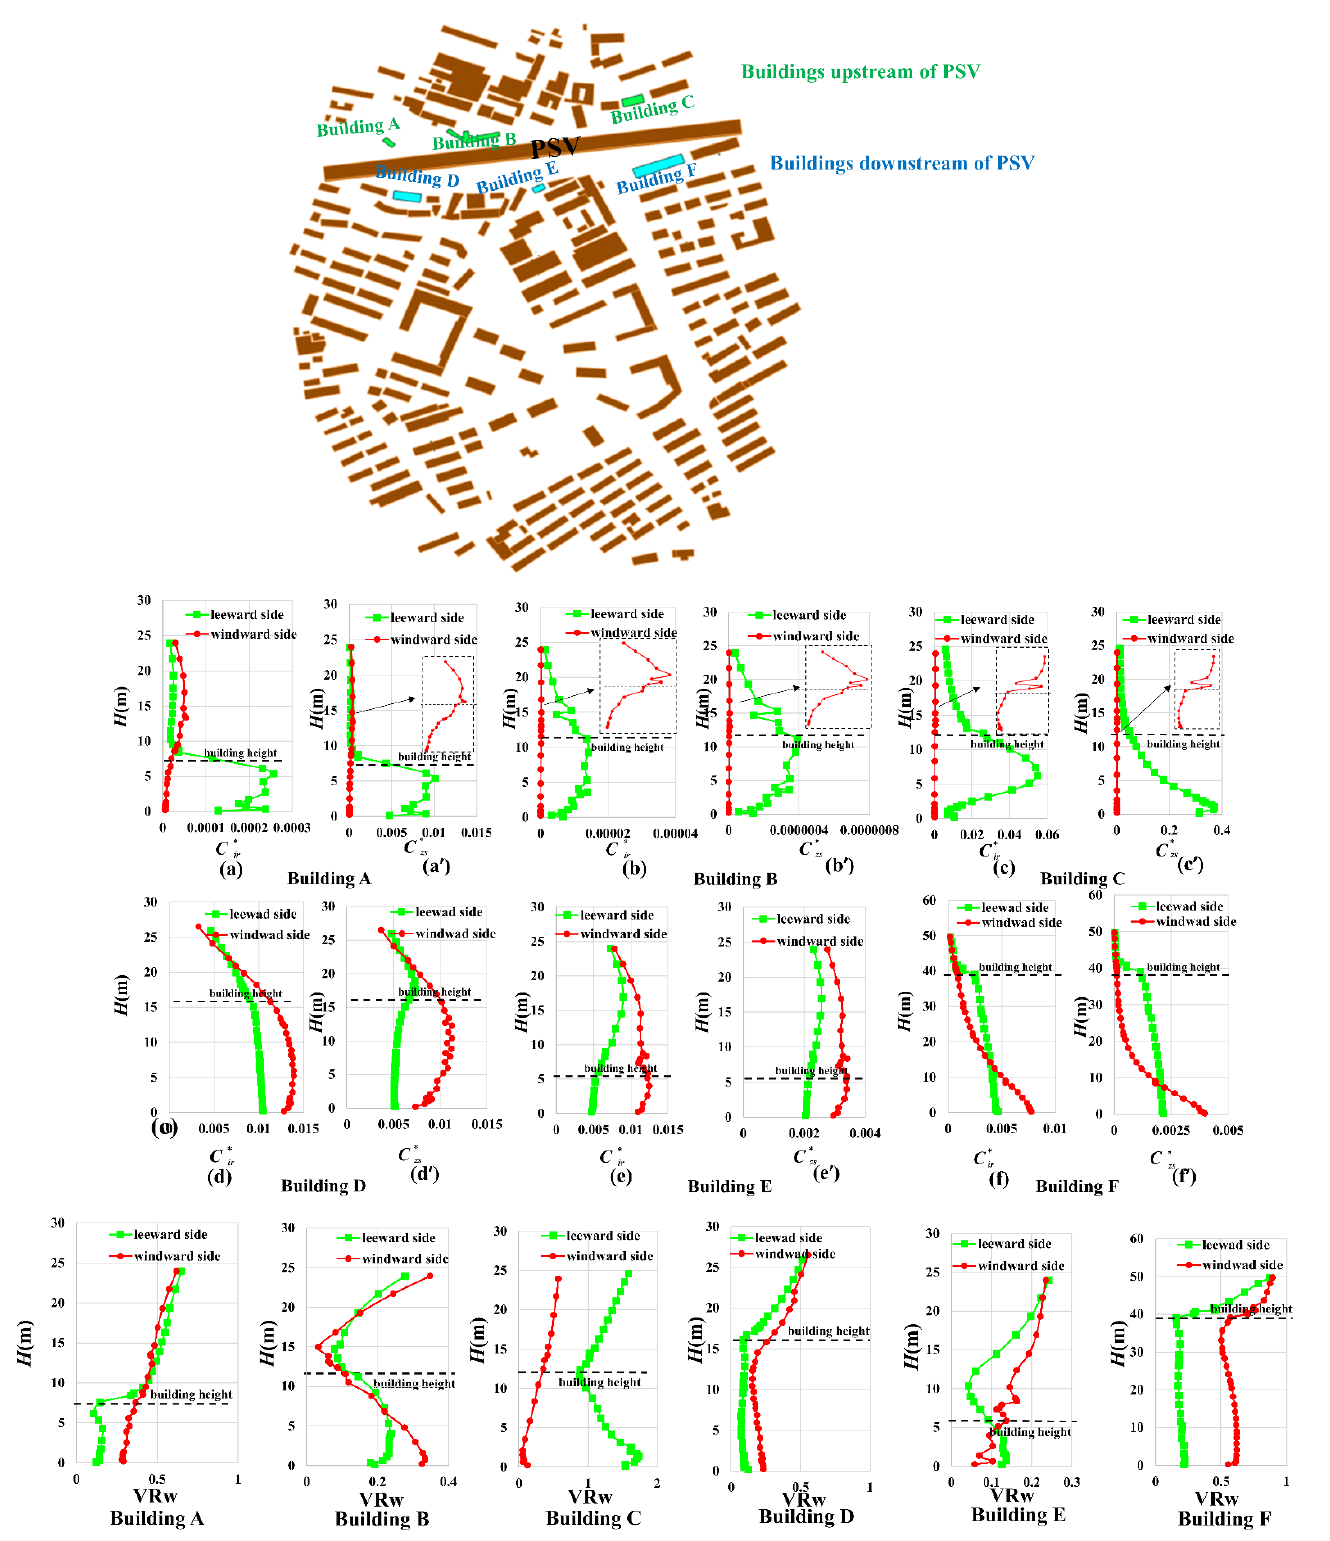
Figure 13. Vertical distributions of normalized mean concentration and VR w of building: the pollutant concentration released from the ground traffic source ( a – f ) and the pollutant concentration released from the viaduct traffic source ( a′ − f ′ ).